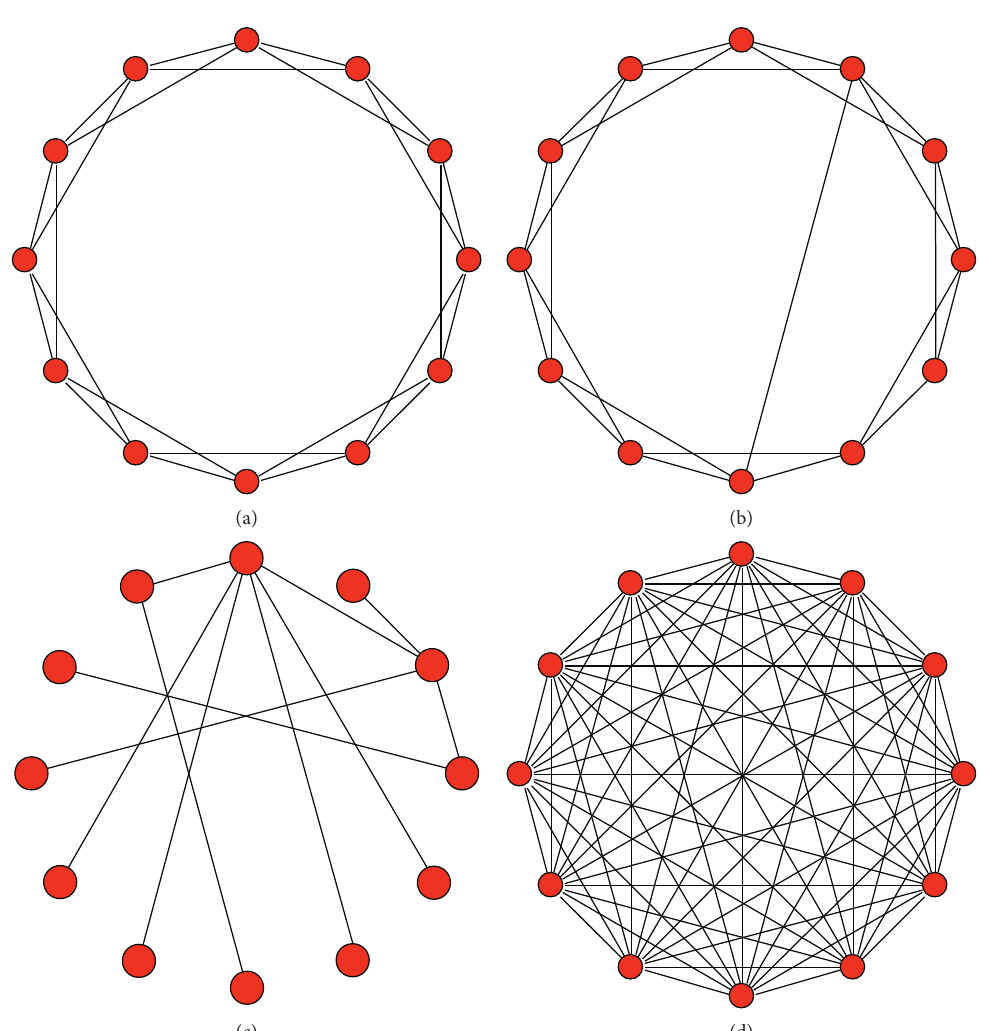
Figure 3: Graphic representation of the four network types. (a) Regular network. (b). Small-world network. (c) Preferentially attached network. (d) Totally connected network.